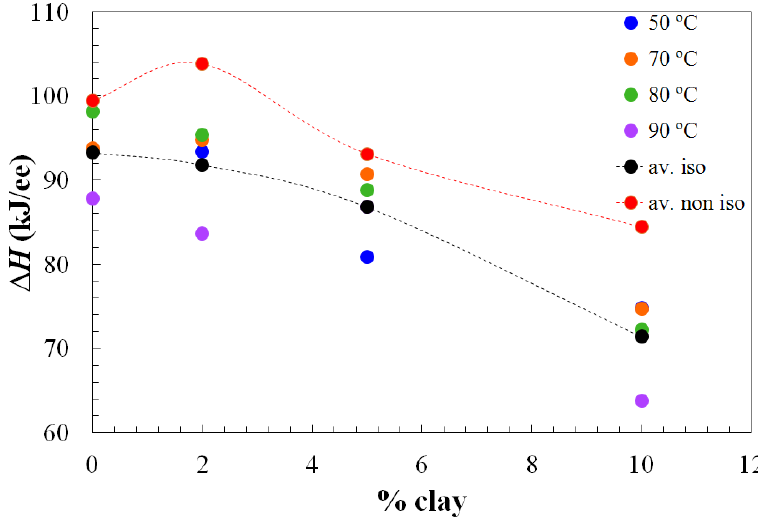
Figure 3. The dependence of the total heat of reaction, ∆ H , on clay content, for the isothermal cure of nanocomposites cured with Lupasol HBP. Dotted black and red lines represent the average values for each percent of clay content, for isothermal (av. iso) and non-isothermal cure (av. non iso), respectively.